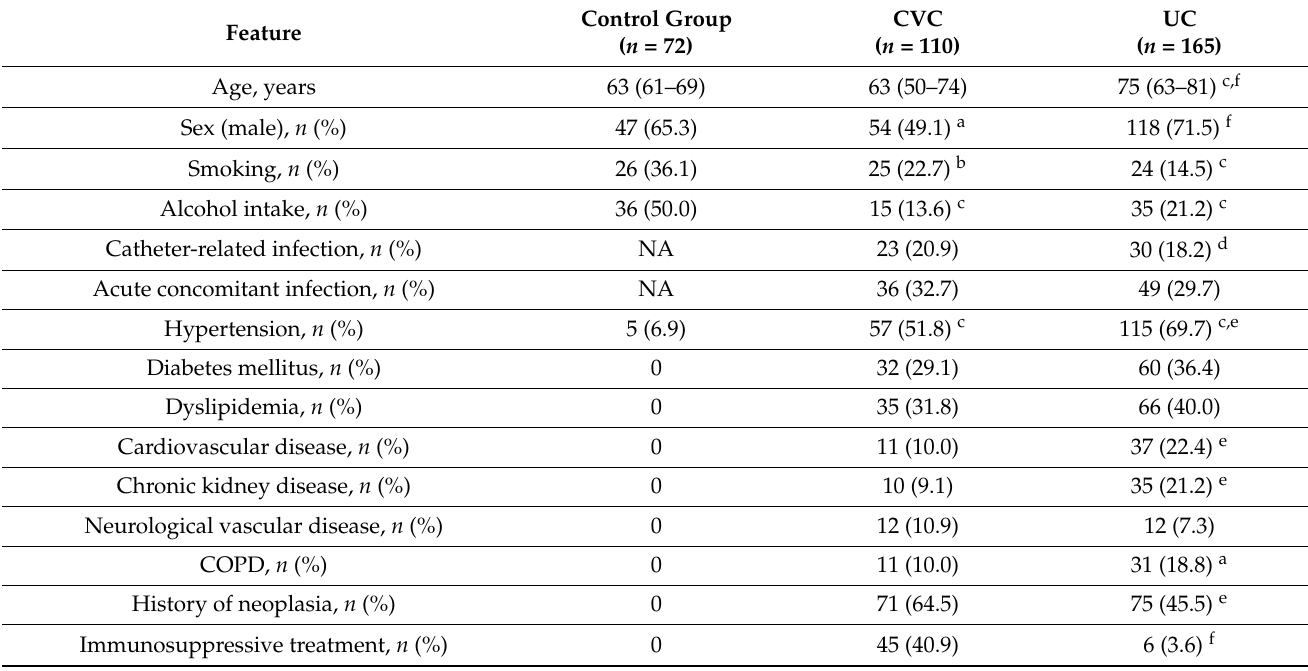
Table 1. Demographic and clinical characteristics of the patients and control